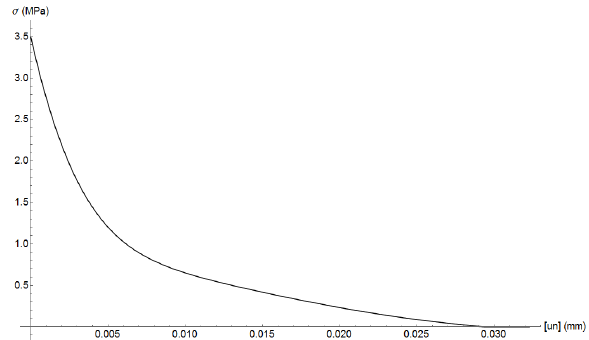
Figure 9. Interfacial transitional zone (ITZ) cohesive curve: tension stress versus crack aperture.